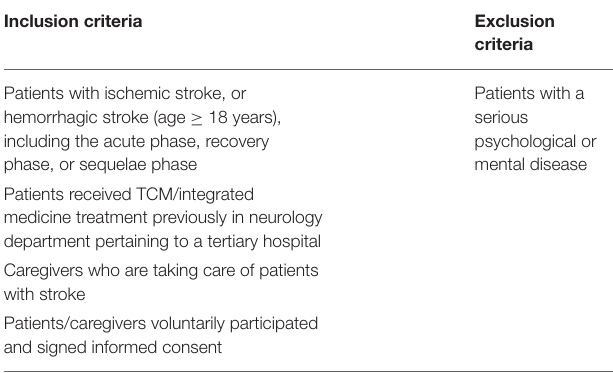
TABLE 1 | The inclusion and exclusion criteria for systematic reviews. TABLE 2 | The inclusion and exclusion criteria for the semi-structured